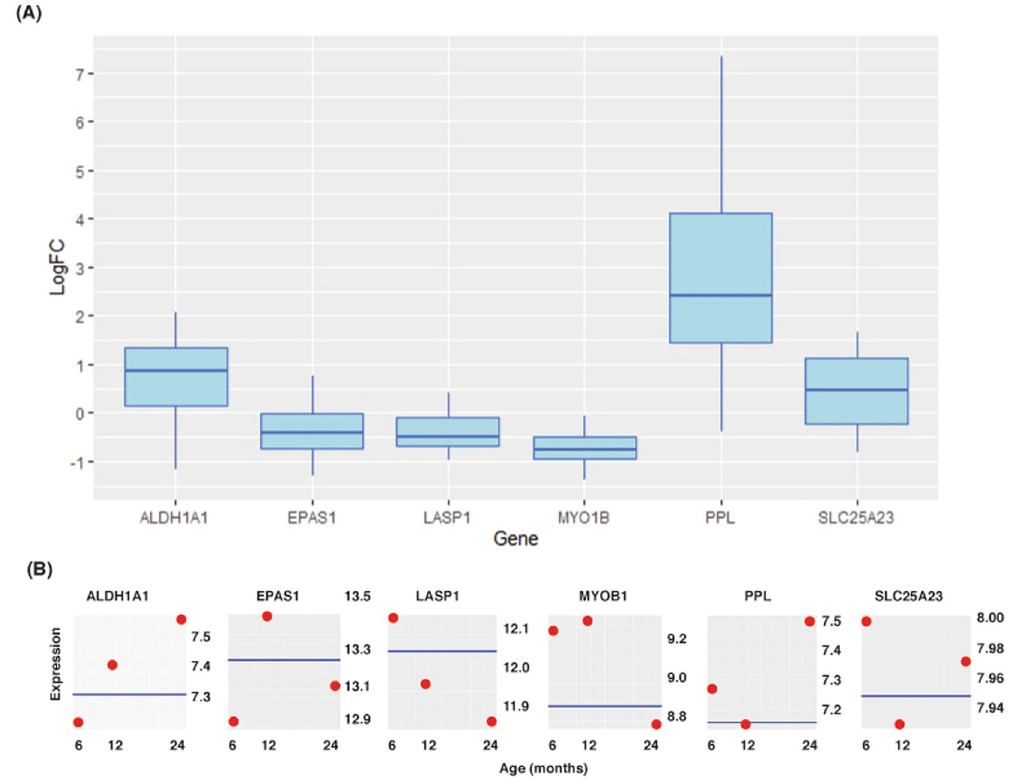
Figure 3. Relative gene expression changes by RT-PCR. An independent set of IH samples in the involution phase (more than 24 mo) and in the proliferation phase (less than 6mo) with n = 6 per group. ( A ) Logarithmic fold change of gene expression between IHs in the involution phase (numerator) and IHs in the proliferation phase (denominator). ( B ) Average gene expression from the microarray experiment (blue line represents the mean level of expression in the propranolol group).